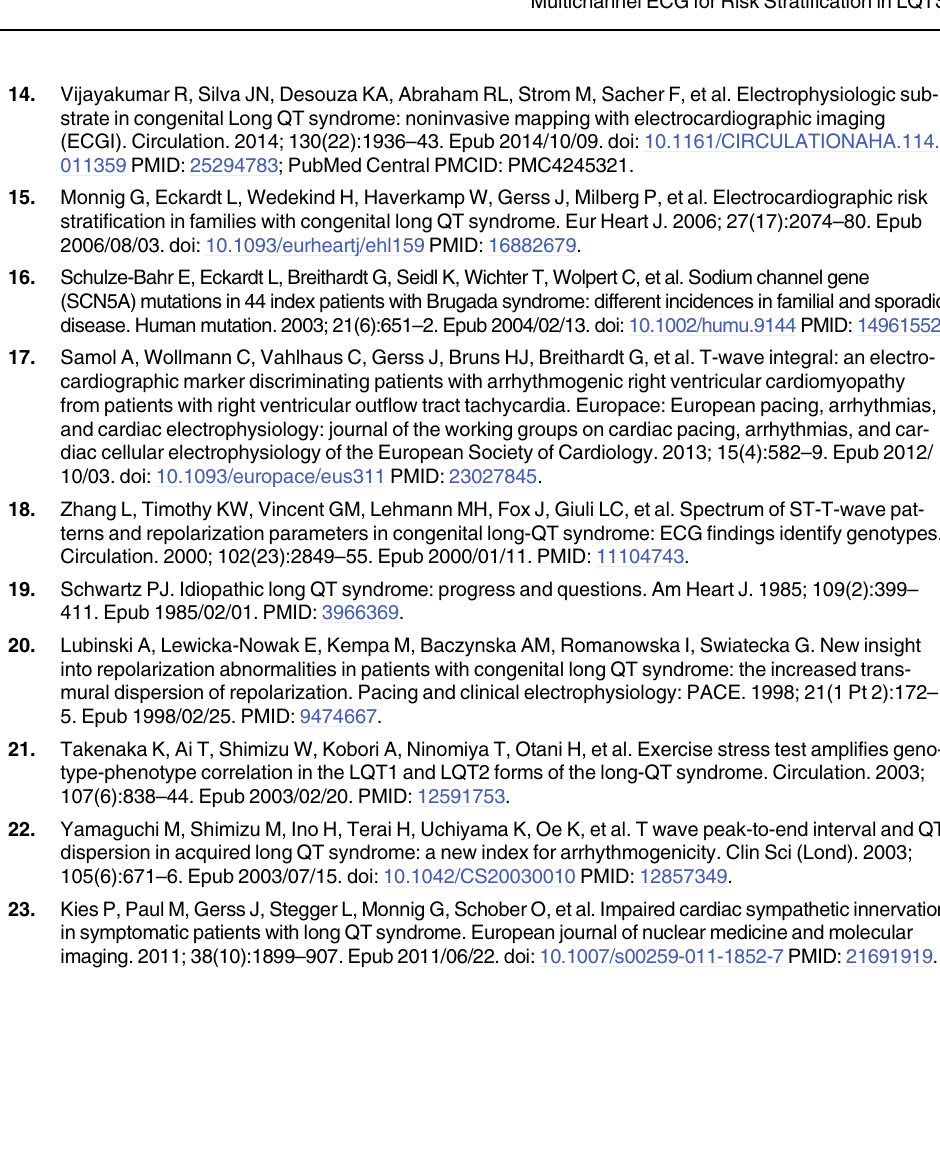
PLOS ONE | DOI:10.1371/journal.pone.0158085 July 5,